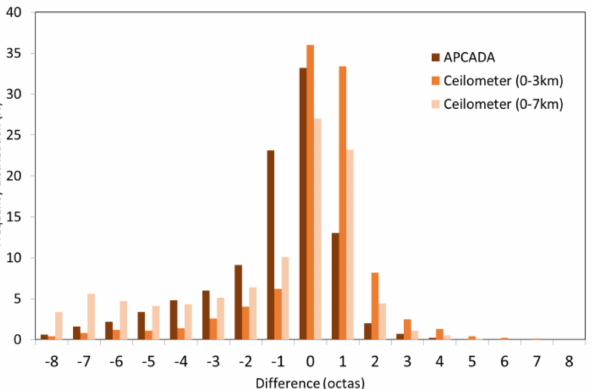
Figure 3. Frequency distribution (%) of absolute difference, in octas, of the cloud amount at low- medium levels derived by the visual and automatic